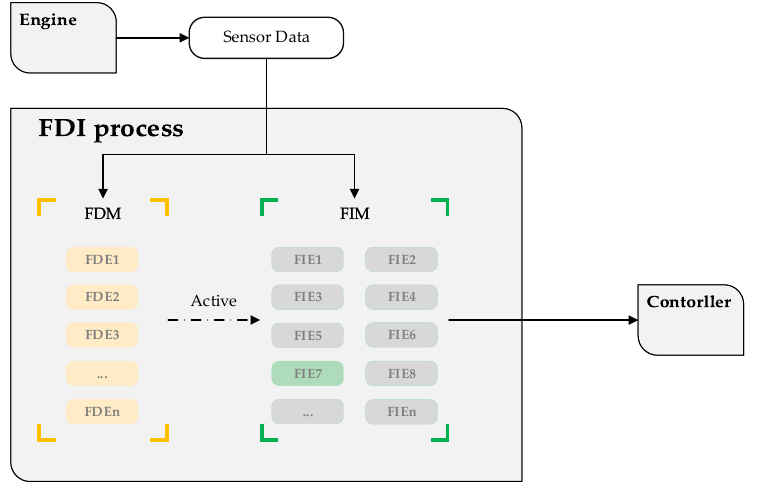
Figure 14. Schematic diagram of FDI process. The Gaussian process regression algorithm is used to build the FIE module.